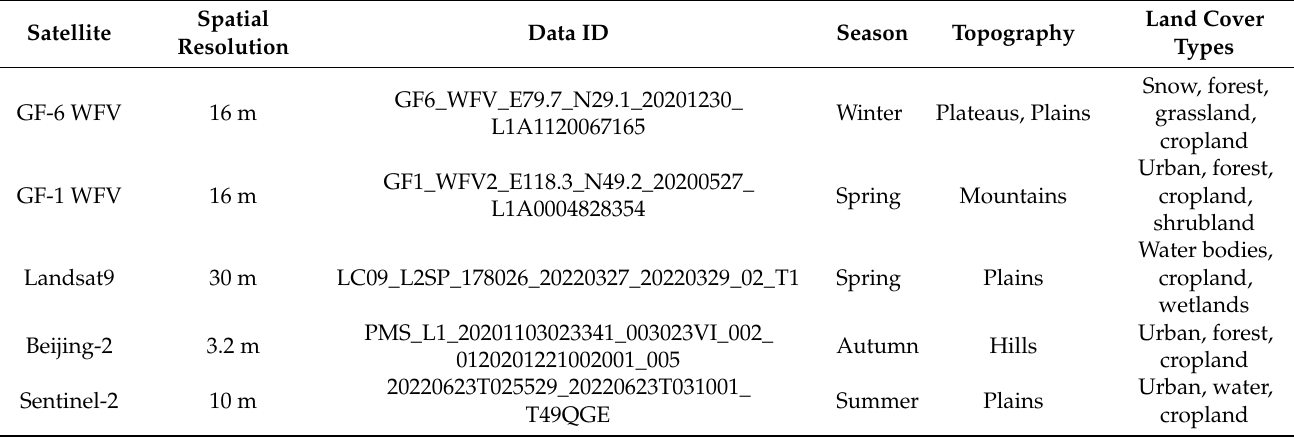
Table 2. The metadata information of multi-source remote sensing